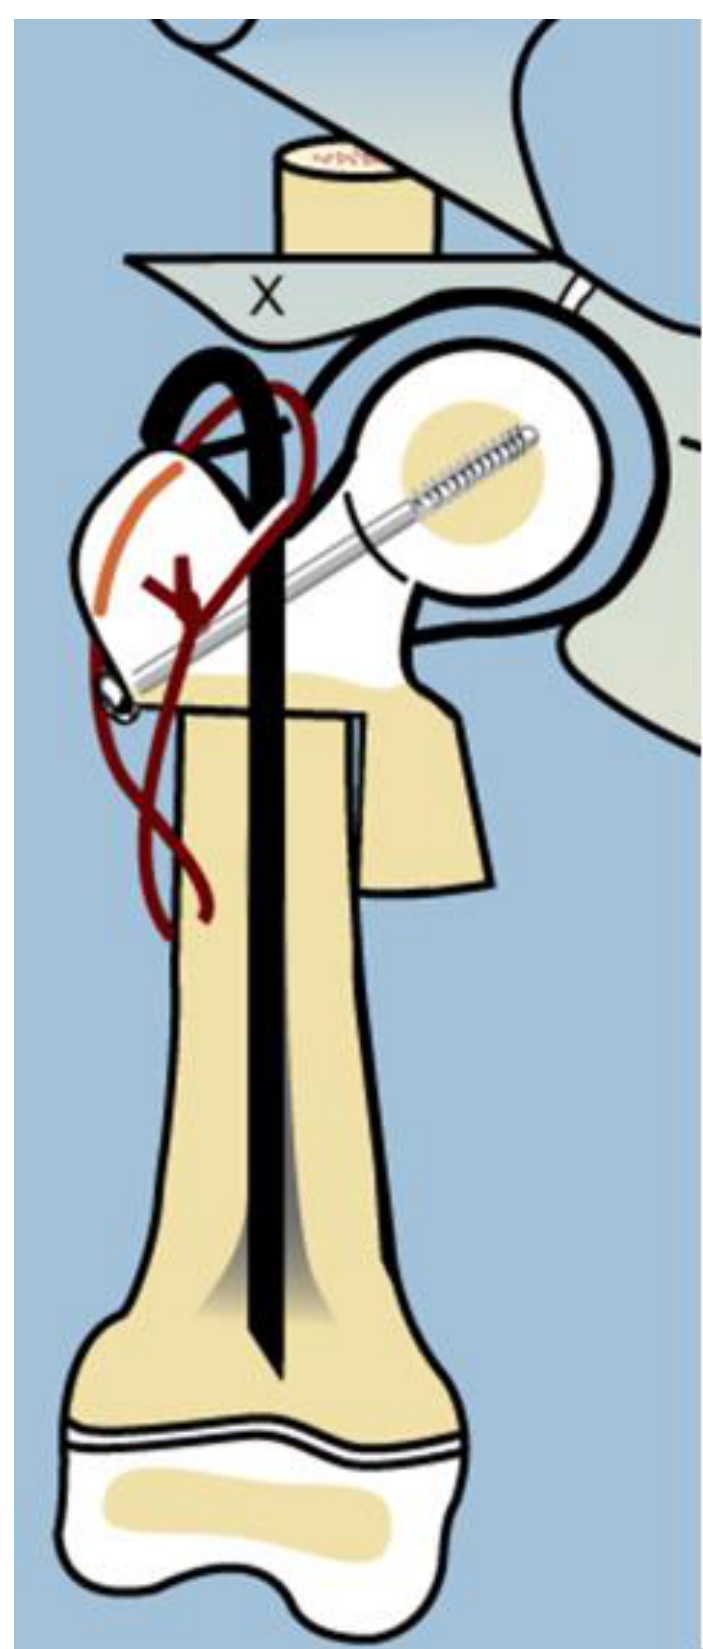
Figure 3. Illustration after SUPERhip procedure using a non-fixed angle device for fixation (Rush rod with tension band wire) and the neck was reinforced with a non-fixed angle screw.